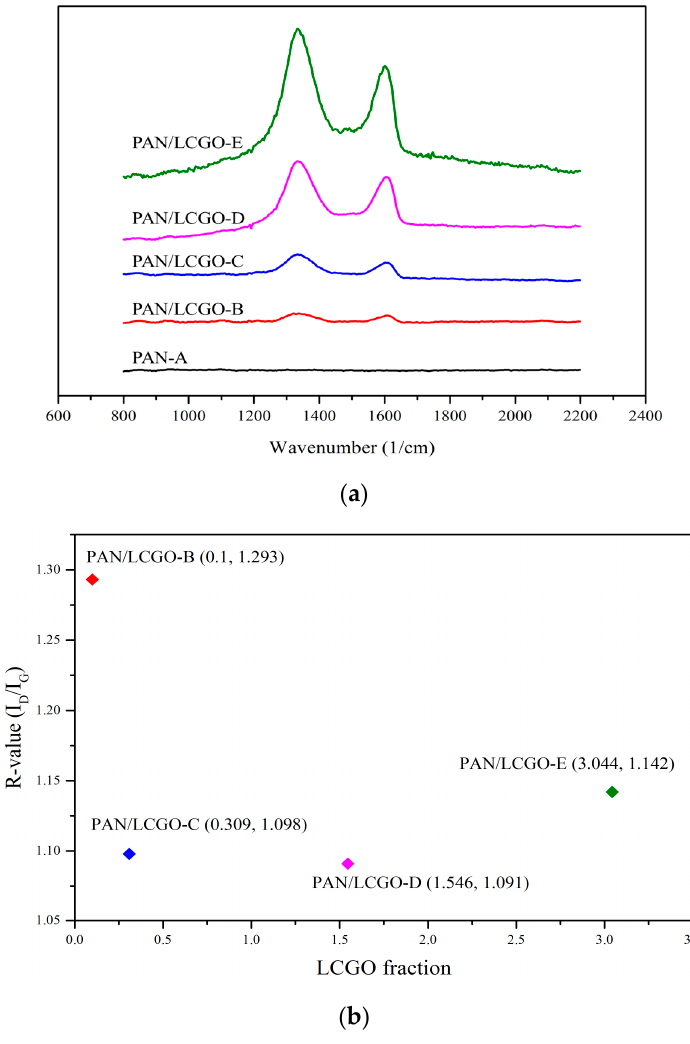
Figure 5. ( a ) Raman spectra of PAN/LCGO nanofibrous mats, and ( b ) R -values for the same samples.